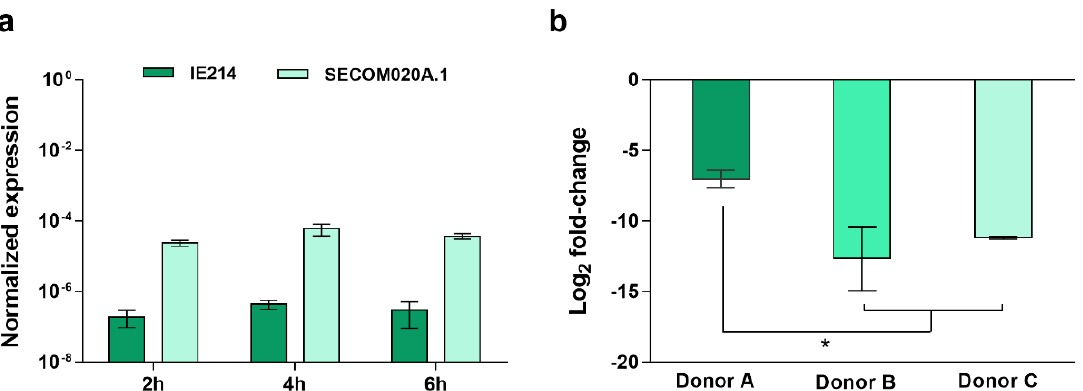
Figure 2. Evaluation of the discriminative potential of the gene SERP2441 . Analysis of the gene SERP2441 expression stability ( a ) over time ( n = 3, using the blood of the same donor) and ( b ) 4 h upon incubation with the blood of three different donors ( n = 2 to 3 technical qPCR replicates). These experiments were performed in strains IE214 (clinical isolate) and SECOM0020A.1 (commensal isolate). Statistical differences among groups were analyzed with one-way ANOVA and Tukey’s multiple comparison test. * p < 0.05.